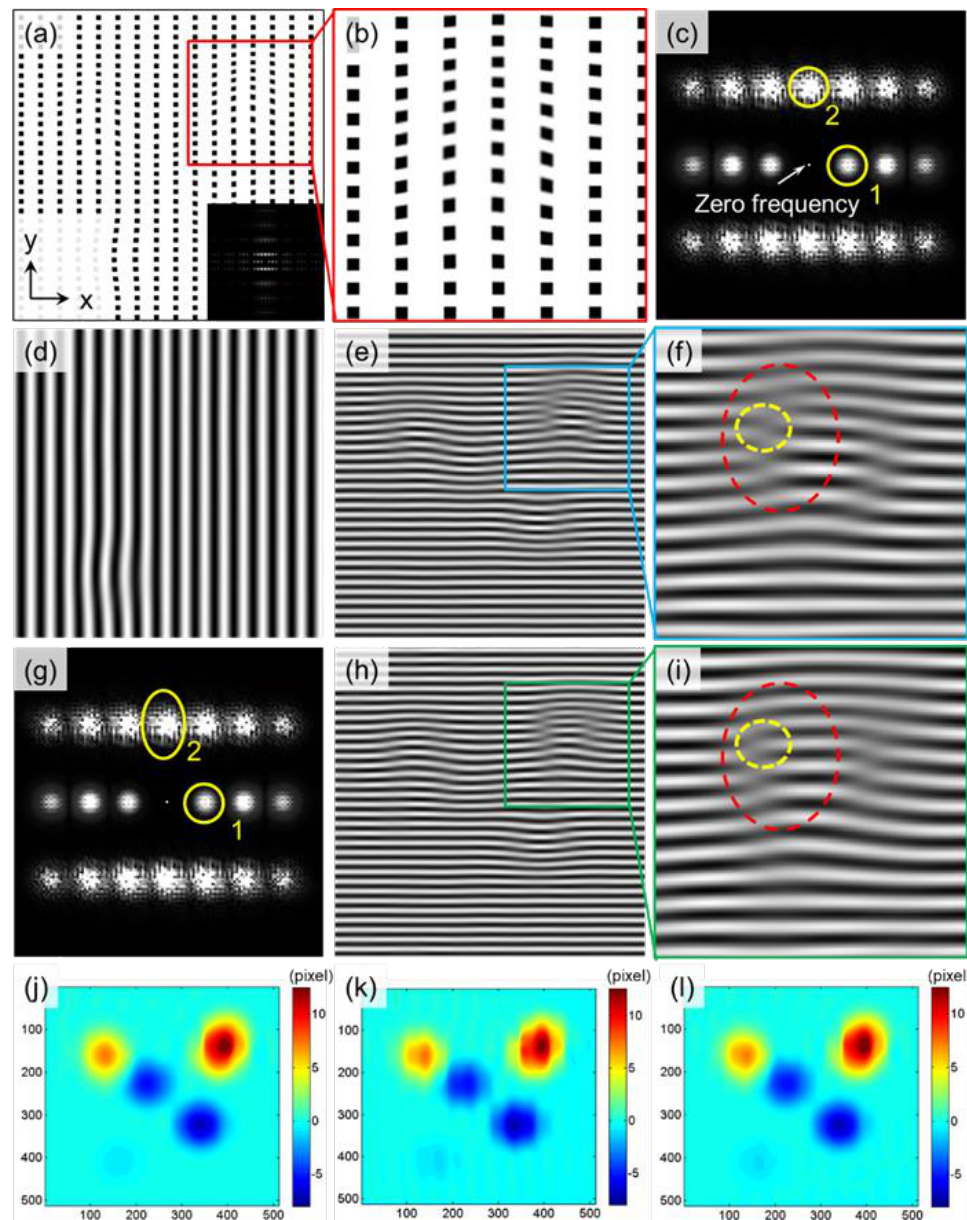
Figure 2. ( a , b ) Constructed lattice image; ( c ) Diffraction spectrum; ( d ) Fringe image of region 1 after IFFT in ( c ); ( e , f ) Fringe image representing region 2 after IFFT in ( c ); ( g ) Diffraction spectrum; ( h , i ) Fringe image representing region 2 after IFFT in ( g ); V − field displacement; ( j ) True value; ( k ) Calculated value using conventional circular window; ( l ) Calculated value using elliptical correction window. Figure3aisaconstructedlatticeimagecontainingdeformationbyusingEquations (5) and (6). The true strain value ε xx is shown in Figure 3b, with a maximum absolute strain value of 0.24. Figure 3c,d show the results calculated by the improved S-GPA and G-GPA, respectively. The window parameters used in the S-GPA are the suggested values from the literature [29]. The window size is set to 10, and the size of the diffraction spot chosen in the G-GPA is g